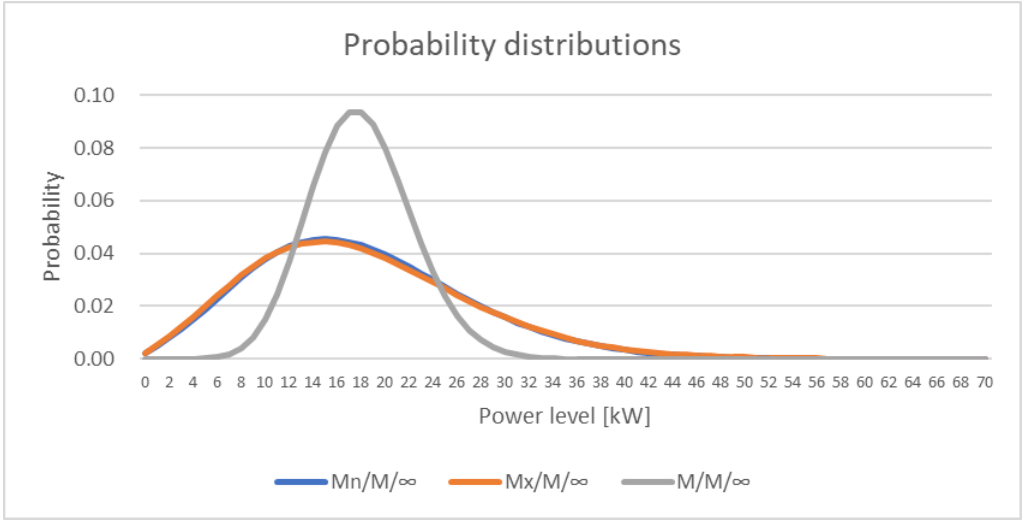
Figure 3. Probability distributions of the states for the three models.